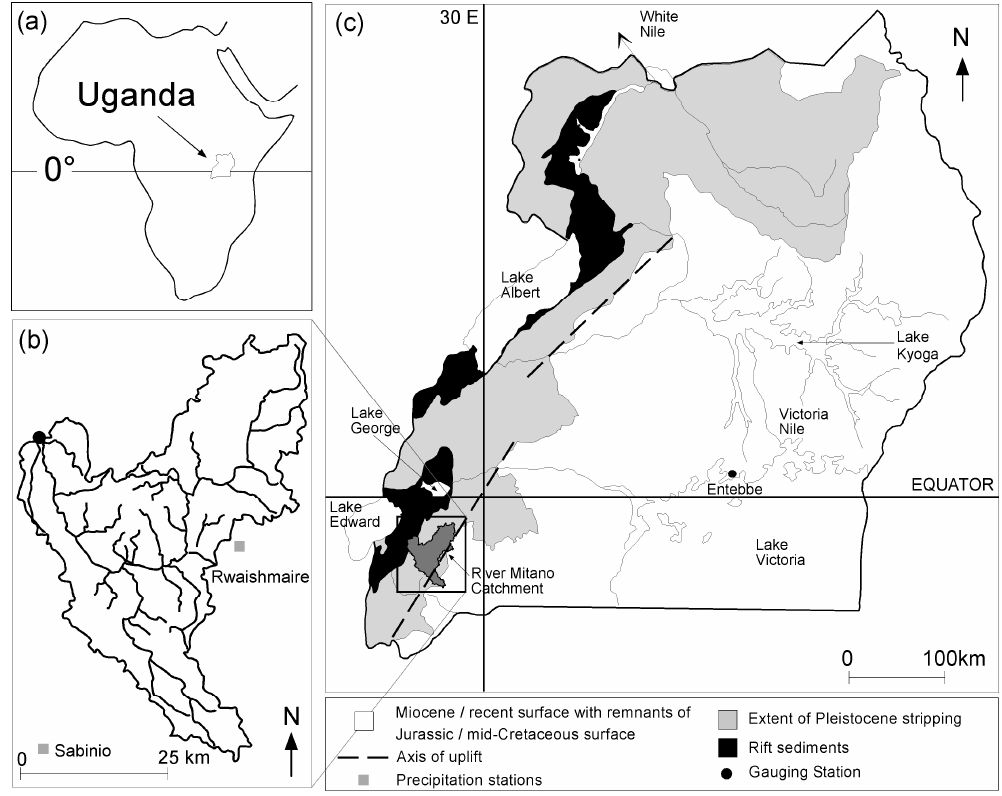
Figure 1 Fig. 1. (a) Location of the River Mitano Basin; (b) detailed map of the catchment drainage system; and (c) the location of the basin